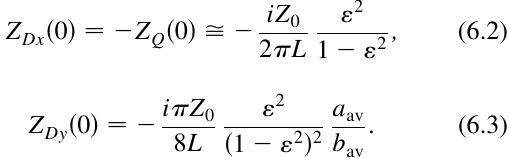
FIG. 14. (Color) Zero-frequency quadrupolar impedance from GDFIDL (symbols) and from first-order perturbation theory Eq. (3.40) (solid line).